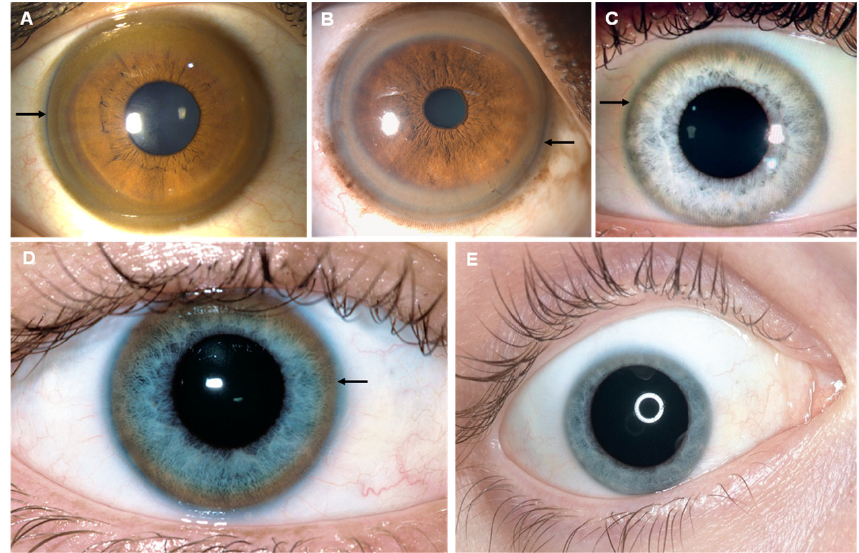
Figure 5. Kayser–Fleischer rings—( A – E ). Reprinted from ( A )—[164], ( B )—[165], ( C )—[166], ( D , E )—[167].